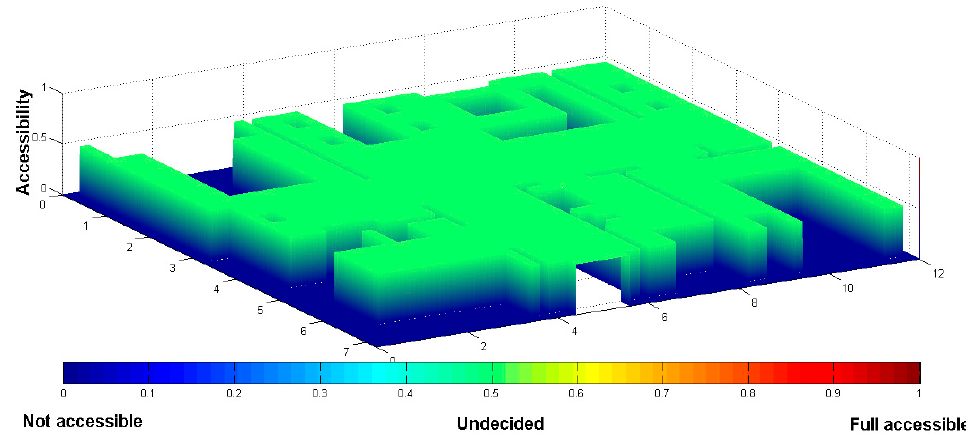
Figure 2. The initial value of the A _ map ( x t , y t ) .